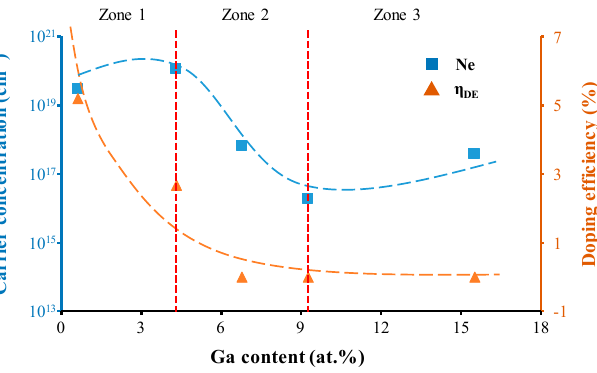
could easily transfer from gallium clusters to ZnO films. Thus, the carrier concentration increased.